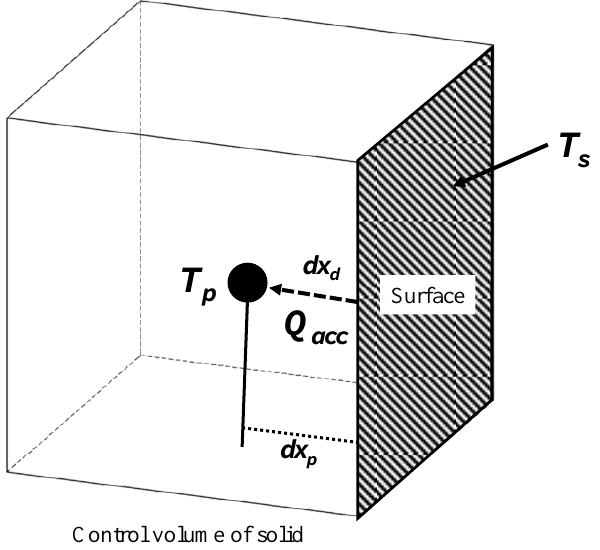
Figure 7. Heat transfer on the solid control volume.